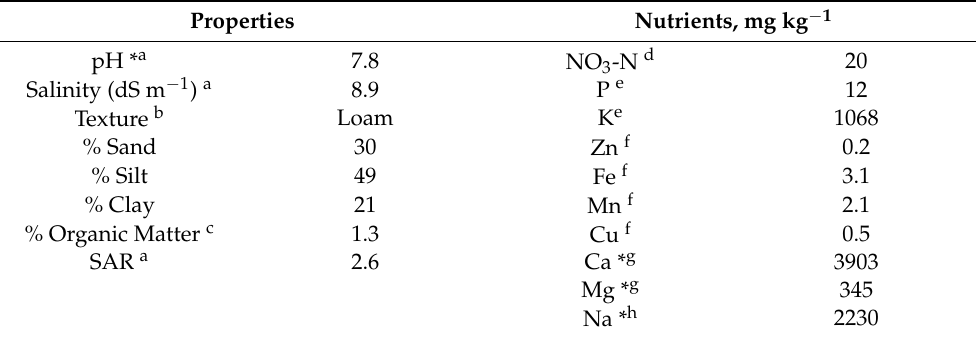
Table 2. Soil properties [49]. Analysis performed at BYU’s Environmental Analytical Laboratory (BYU-EAL, https://pws.byu.edu/eal (accessed on 13 May 2022)) except where noted. Properties marked with “*” were analyzed at Servi-Tech Laboratories (www.servitechlabs.com (accessed on 24 May 2022)).